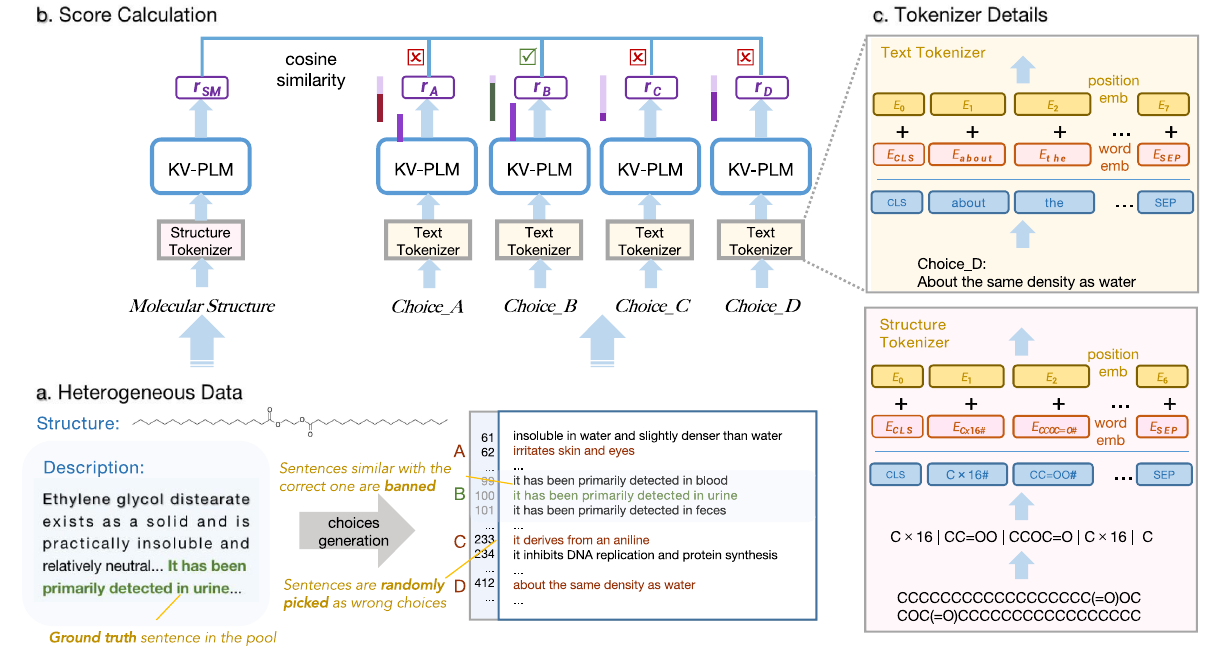
Fig. 2 Schematic diagram for KV-PLM* fi nishing CHEMIchoice task. For the given unfamiliar molecule entity, we get a versatile materials including structure and description, from which we know the correct sentence and randomly pick wrong sentences from the pool to form four choices. b Molecule structure and text of choices are fed into KV-PLM* and get their representations, based on which the con fi dence scores of choices are calculated by cosine similarity. c The tokenizers for structures and biomedical text are different. In this instance, KV-PLM* successfully fi nds out the correct description sentence for the given